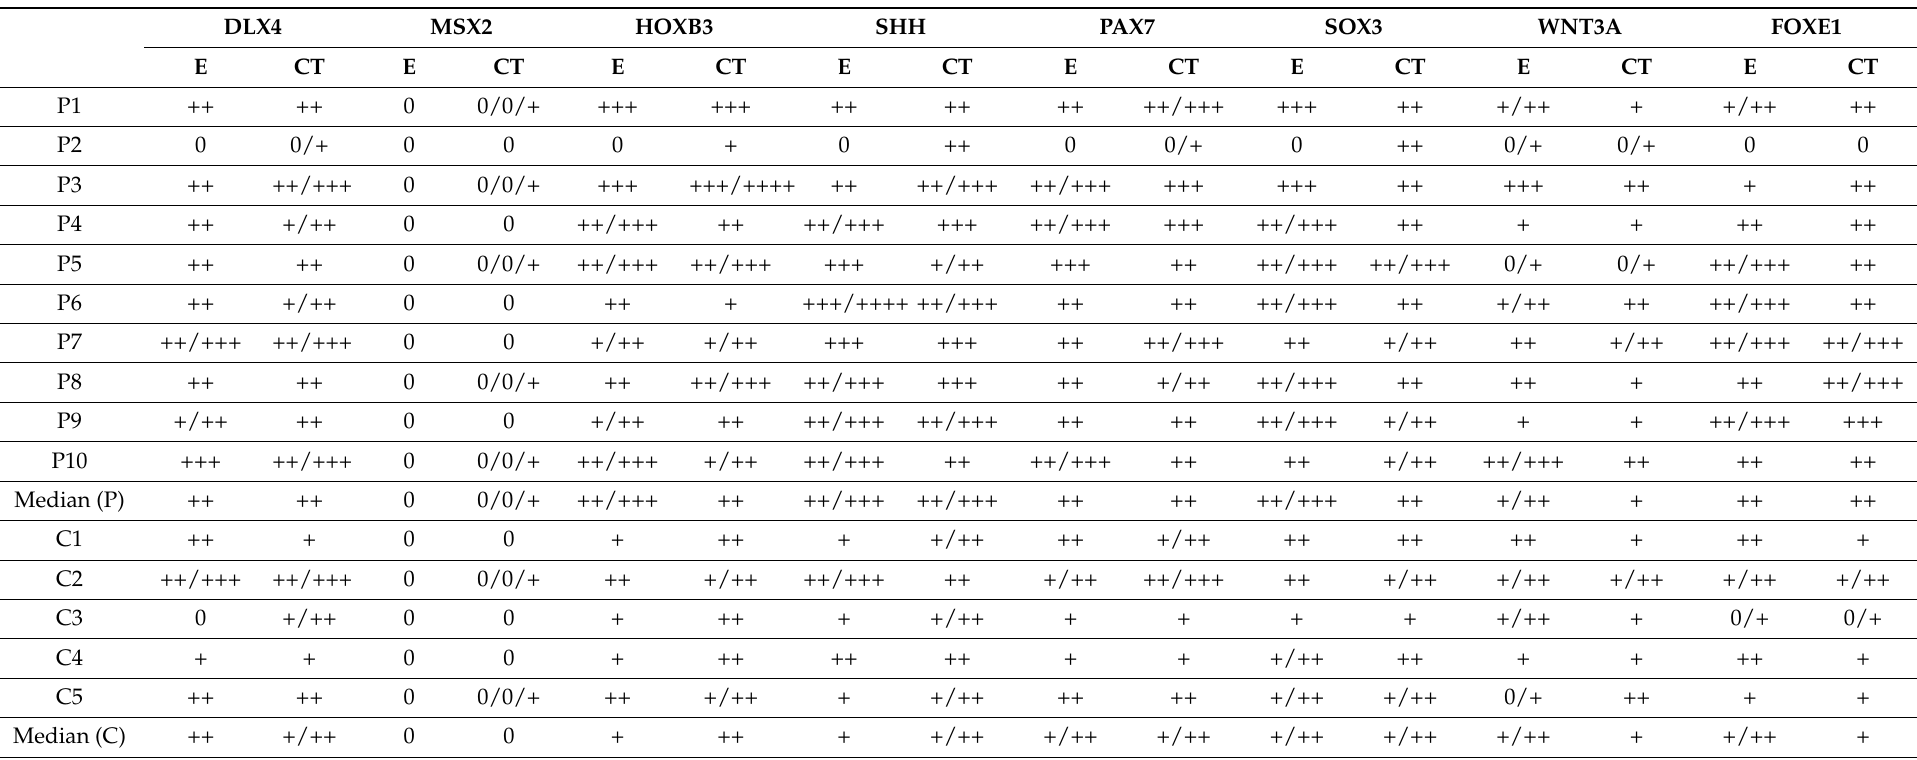
Table 3. Median values of semiquantitative evaluation of DLX4, MSX2, HOXB3, SHH, PAX7, SOX3, WNT3A and FOXE1 in patient and control